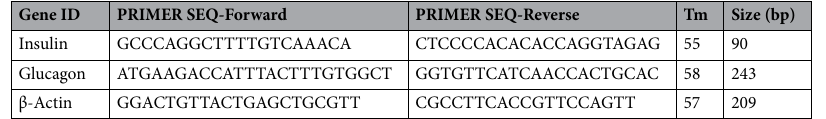
Table 3. Summarizes details of RT-PCR primer sequences and PCR conditions for islet cell differentiation markers.